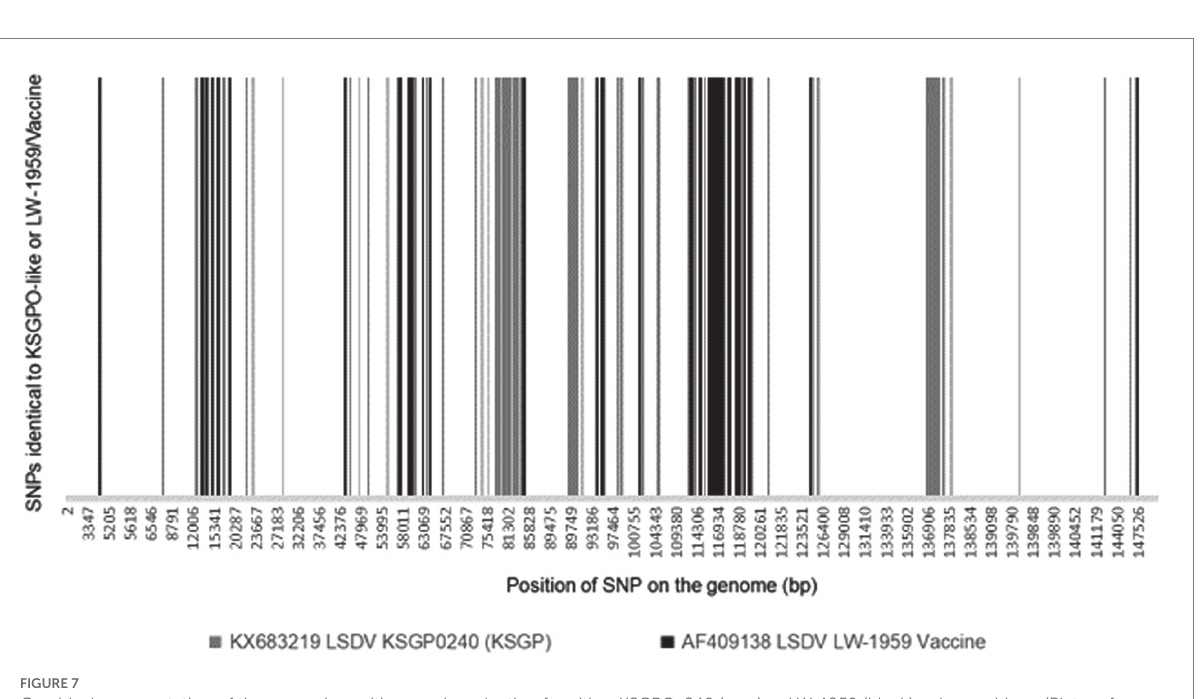
FIGURE 6 Graphical representation of the genomic position of each SNPs identical to LSDV/KSGPO-240/Kenya/1958 (gray) or LSDV/LW-1959/Vaccine (black), in the genome of (A) LSDV/Russia/Saratov/2017; (B) LSDV/Russia/Udmurtya/2019; (C) LSDV/Russia/Tyumen/2019; (D) LSDV Kostanay/ Kazakhstan/2018; (E) LSDV/GD01/China/2020 (Picture from Krotova et al., 2022a).